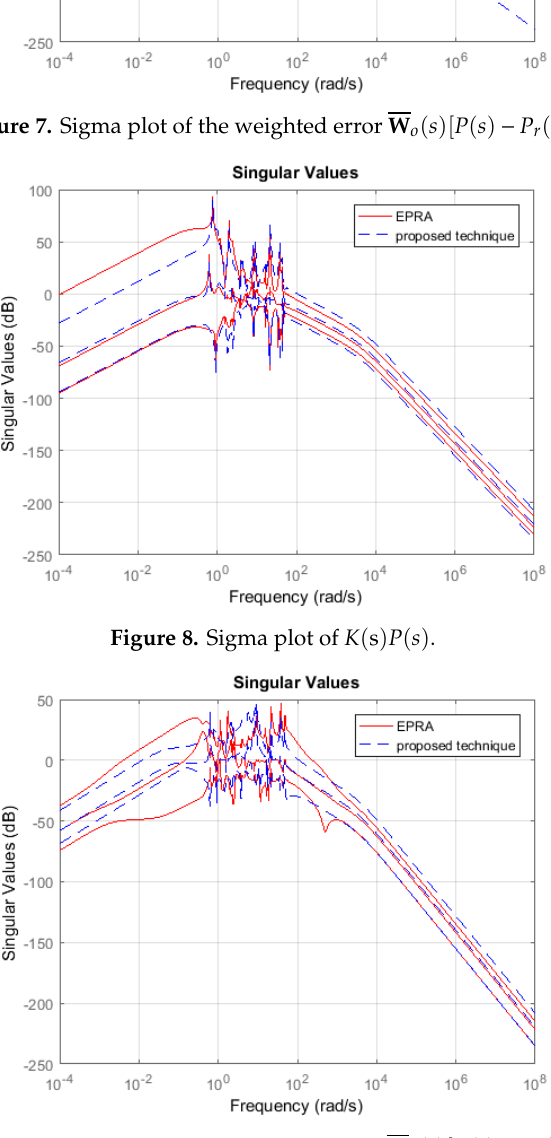
Figure 9. Sigma plot of the weighted error W ̅̅̅ 𝑜 (𝑠)[𝐾(𝑠) − 𝐾 𝑟 (𝑠)].